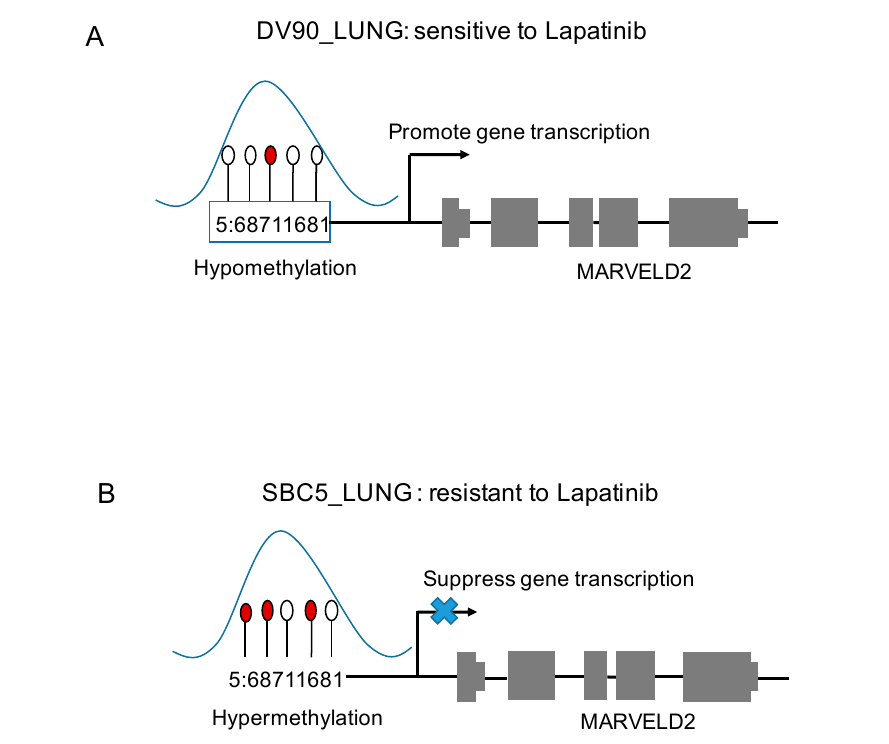
Figure 7. The relationship between methylation and gene expression. ( A ) In lung cancer samples sensitive to Lapatinib (DV90_LUNG), methylation site—5:68711681 hypomethylation may promote the transcription of MARVELD2 gene. ( B ) In lung cancer samples resistant to Lapatinib (SBC5_LUNG), methylation site—5:68711681 hypermethylation may suppress the transcription of MARVELD2 gene.